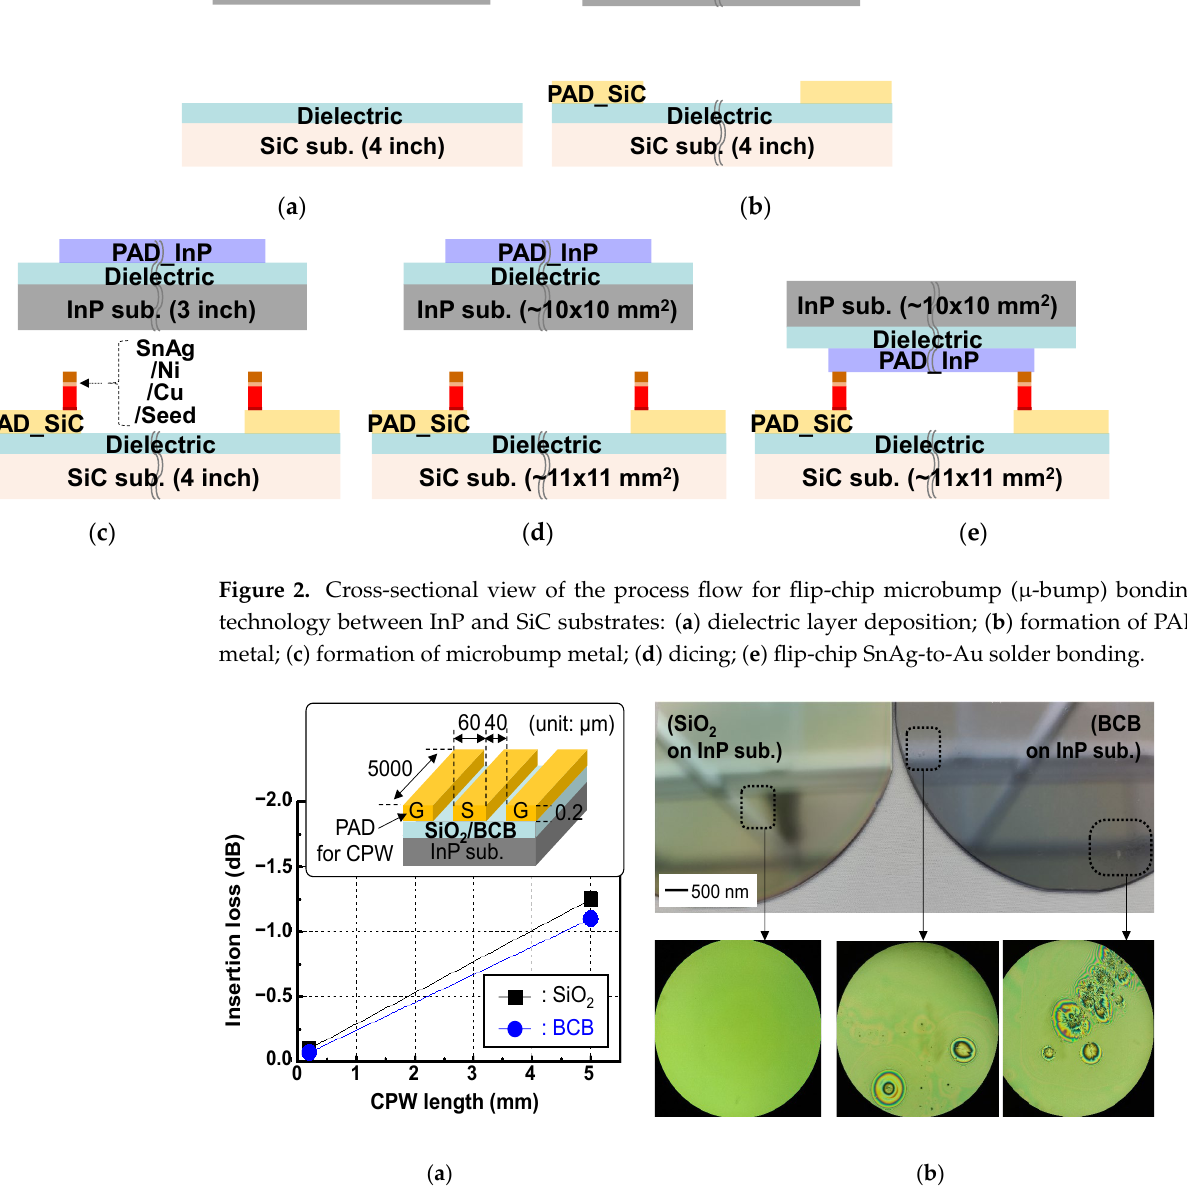
Figure 3. Implementation results of coplanar waveguides (CPWs) with different dielectric layers of SiO 2 and BCB: ( a ) measured insertion loss of fabricated SiO 2 - and BCB-based coplanar waveguide (CPW) lines. The inset shows a structural diagram of the fabricated CPW lines; ( b ) microscope images immediately after deposition of SiO 2 and BCB layers on InP substrates.